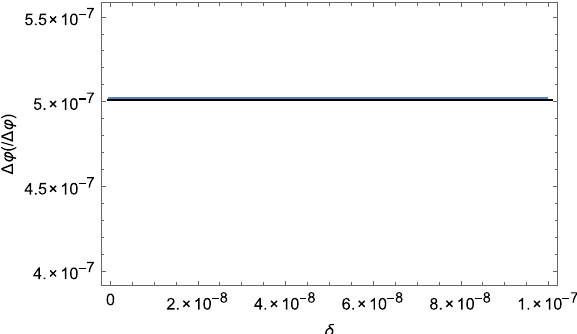
Fig. 8 Plot for the perihelion shift with extremely small values of δ